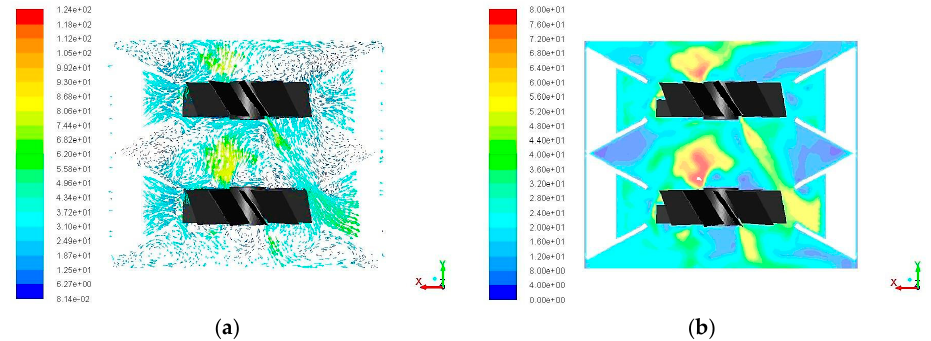
Figure 18. ( a ) Velocity vectors (m/s); ( b ) contours of velocity (m/s) on xy plane and the center of the rotor for two-stage KIONAS, rotor blade angle of 35° and stator with curved guide vanes.